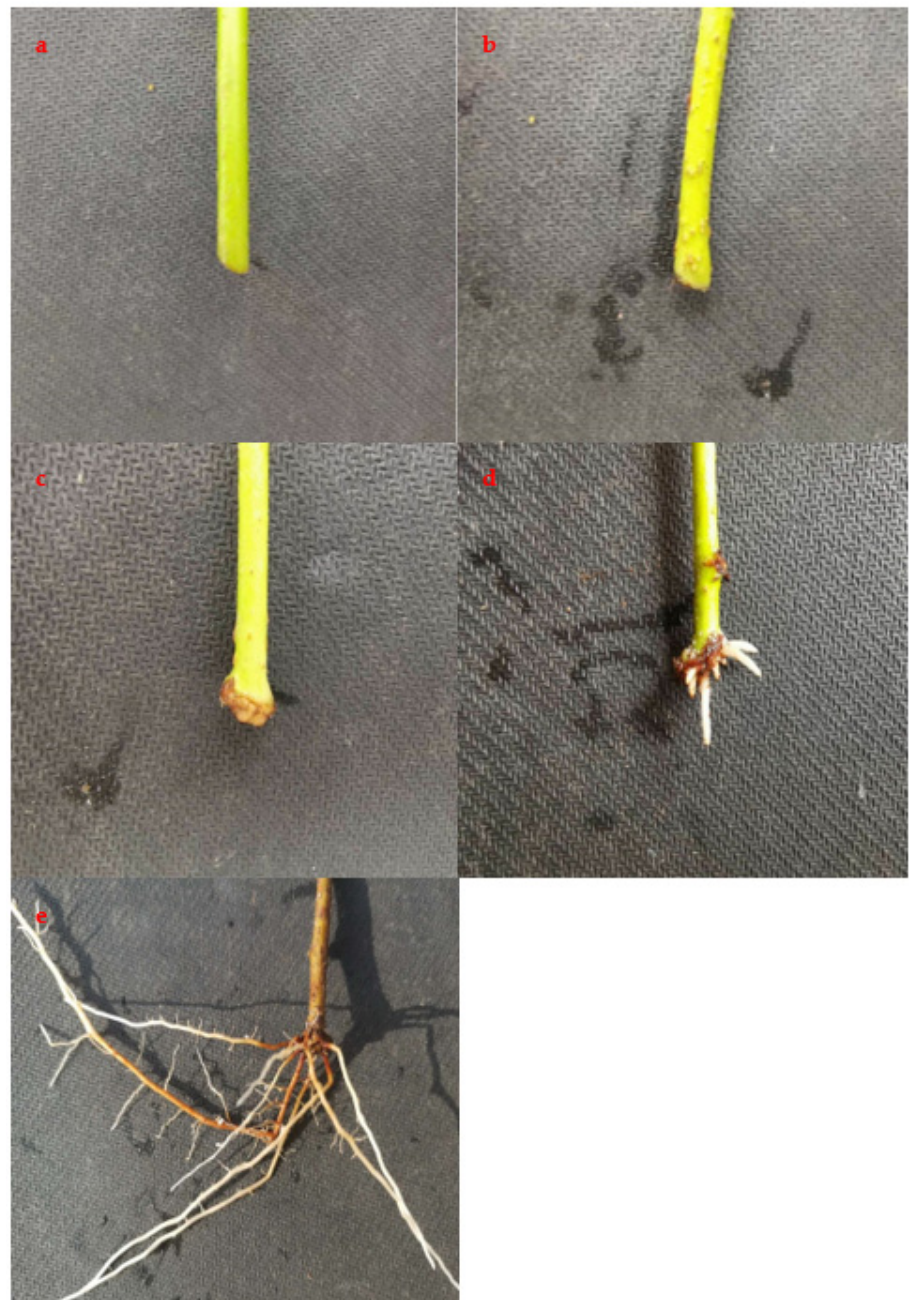
Figure 2. Phenotypic properties of adventitious root development in the cutting bases from 7-year-old ortets at the 0th- ( a ), 10th- ( b ), 20th- ( c ), 40th- ( d ) and 60th day ( e ) during cultivation, respec- tively.